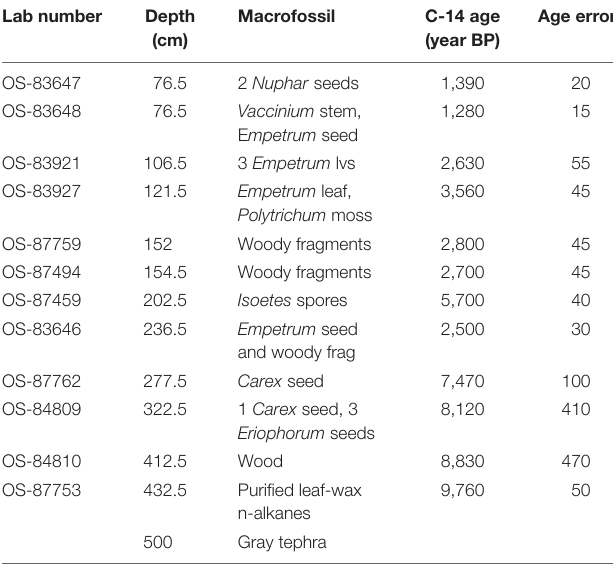
TABLE 1 | AMS radiocarbon depths, macrofossil identification, and 14 C